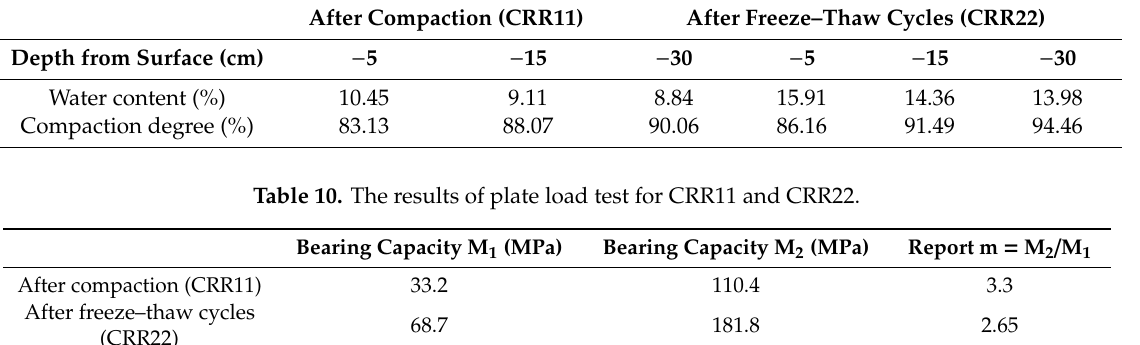
Table 9. The results of gamma densimeter measurement of road foundation after the compaction (CRR11) and freeze–thaw cycles (CRR22).